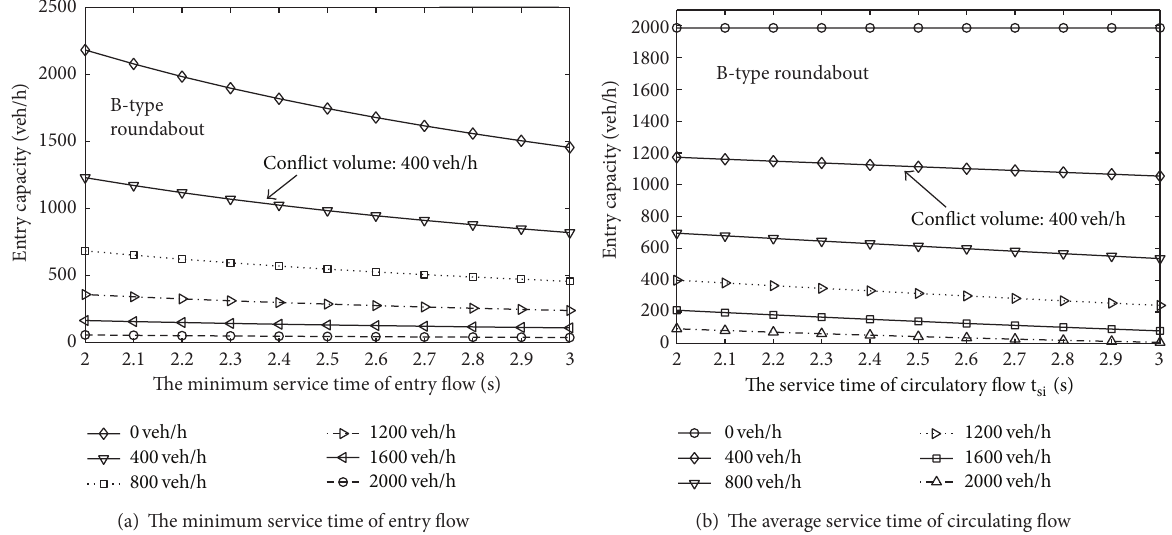
Figure 3: Sensitivity analysis of B-type